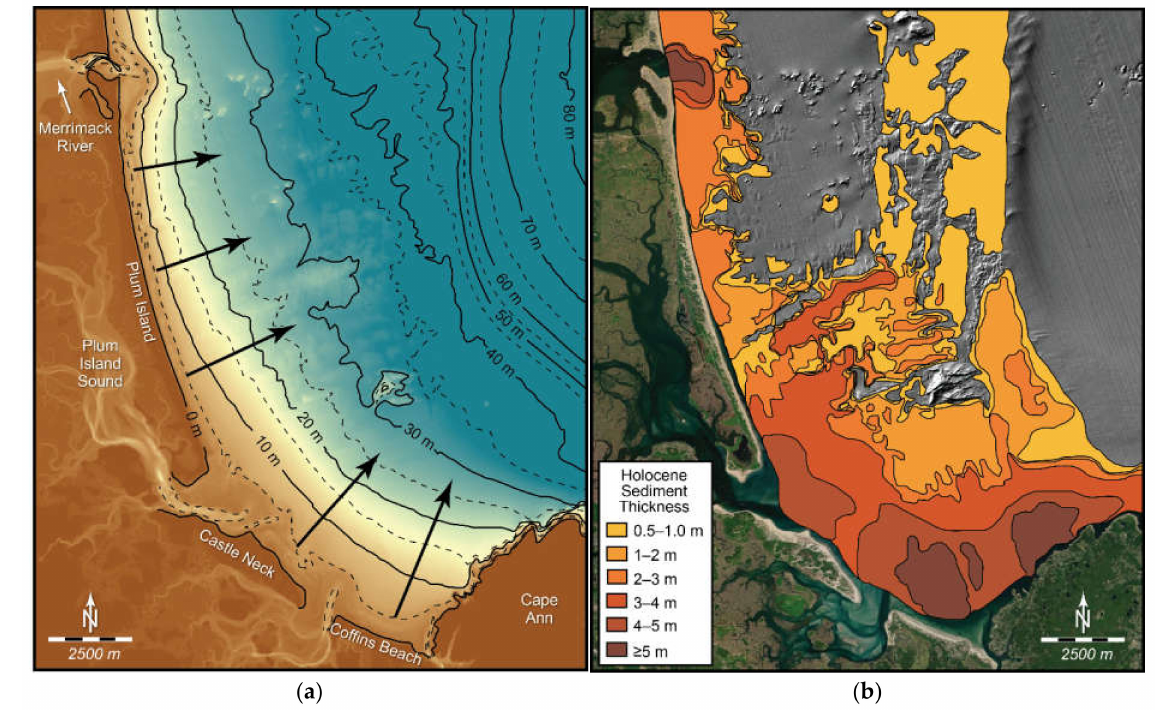
Figure 4. Long-term southerly longshore transport of sediment evidenced by ( a ) seaward excursion of depth contours offshore of Plum Island and Castle Neck (see arrows), and ( b ) an isopach map showing that the Holocene sediment thickness increase from the mouth of the Merrimack (2–3 m) to >5 m adjacent to the Cape Ann promontory. Digital elevation model in ( a ) is from the NOAA National Centers for Environmental Information Continuously Updated Digital Elevation Model (CUDEM) (https://coast.noaa.gov/htdata/raster2/elevation/NCEI_ninth_Topobathy_2014_8483/; accessed 30 January 2022). Part ( b ) is based on seismic-reflection profiles, high-resolution bathymetric and sidescan-sonar backscatter intensity data, and analysis of [58,59]. Background hill-shaded bathymetric digital elevation model is from